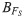
Wound geometry and model structure.(a) The wound is pictured in the transverse plane. The (liquid) exudate overlies the host cells, while a layer of necrotic tissue covers the wound, except at the excision where the exudate is exposed to the air. (b) The processes described in the mathematical model as they relate to the wound geometry (the diagram does not distinguish between susceptible and resistant bacteria, nor does it depict conjugation or segregation). (c) A representation of the model topology (Eqs 1–11). BFS: free susceptible bacteria, BFR: free resistant bacteria, BBS: bound susceptible bacteria, BBR: bound resistant bacteria, IF: free inhibitors, IB: bound inhibitors, and A: antibiotic. Antibiotic directly inhibits bacteria by killing them, while inhibitors indirectly inhibit bacteria by limiting their ability to bind to host cells. The intrinsic growth rate of susceptible bacteria is greater than that of resistant bacteria, while the maximum killing rate of susceptible bacteria by antibiotic is greater than that for resistant bacteria. This is represented by thicker arrows/inhibition symbols in each case. See Table 1 for variable descriptions and units, and Tables 2–4 for parameter descriptions and units.